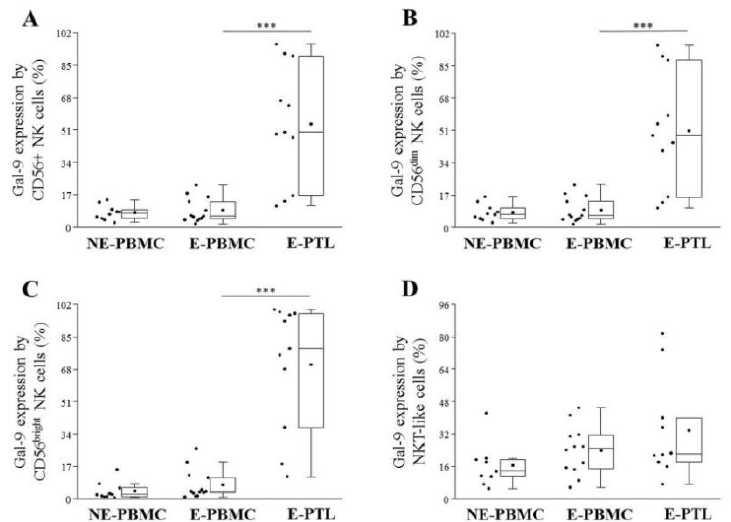
Figure 6. Comparison of the cell surface Gal-9 expression by peripheral (PBMC) and peritoneal (PTL) CD56 + NK ( A ), CD56 dim NK ( B ), CD56 bright ( C ) and NKT-like ( D ) cell subpopulations in non-endometriotic (NE) women and patients with endometriosis (E). The solid bars represent medians of 10, 12, and 11 determinations; the boxes show the interquartile ranges, and the whiskers show the most extreme observations. The middle square within the box shows the mean value. Statistically significant di ff erences for p -values of *** < 0.01 are